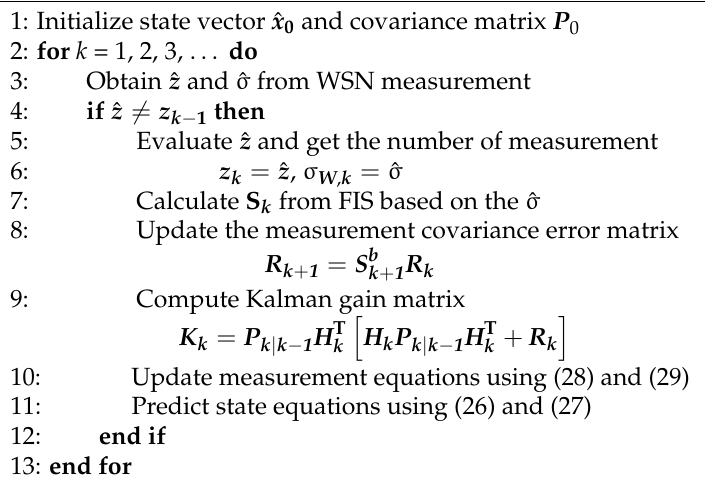
Algorithm 1. Summary of the SINS/WSN FATCI